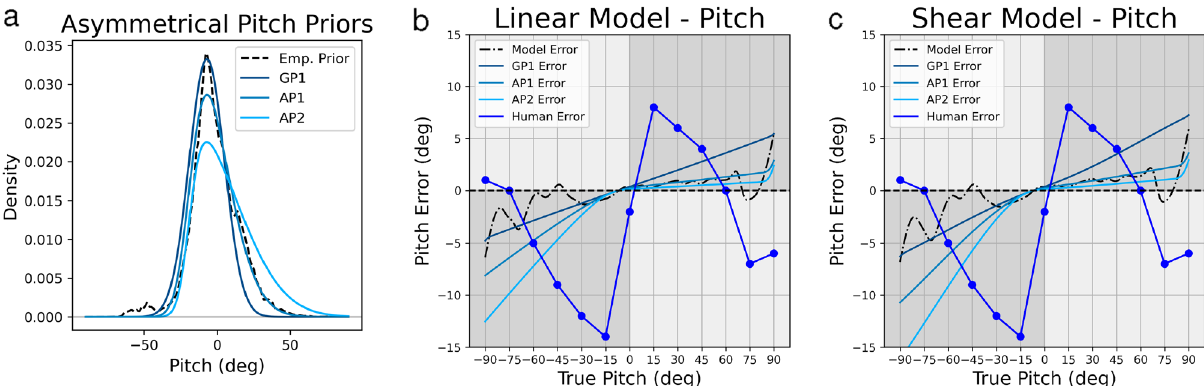
Figure 7. Head pitch perception error modeling using Gaussian and skew normal priors. Gaussian and skew normal priors are plotted in ( a ) in light blue, while the empirical roll prior is plotted in dashed black. Increasingly asymmetric predictions are seen when using these as priors in the linear model ( b ) and the shear model ( c ). Model predictions using a given prior are plotted in dashed black and light blue, while psychophysical roll perception data from previous work are plotted in dark